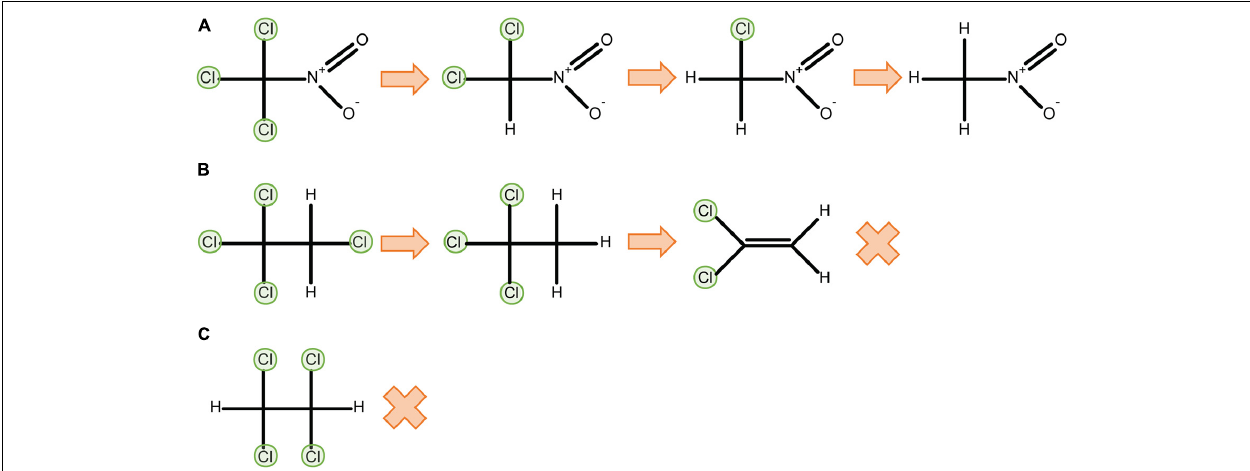
FIGURE 3 | Physicochemical properties such as bond polarisation affect reductive dehalogenation. P450 CAM can fully dechlorinate trichloronitromethane through reductive reactions (A) , but only partially dechlorinates 1,1,1,2-tetrachloroethane to 1,1-dichloroethylene (B) . 1,1,2,2-tetrachloroethane cannot be metabolised by P450 CAM in reductive conditions (C) (Logan et al.,